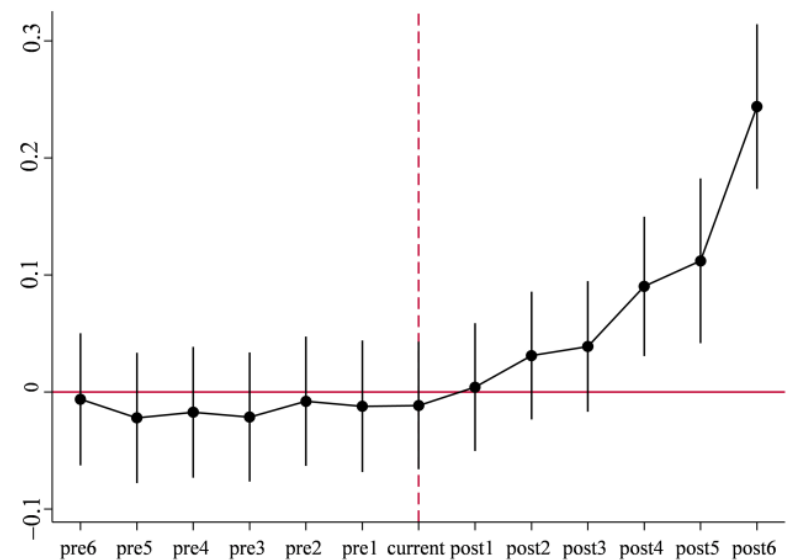
Figure 4. Parallel trend testing after PSM.